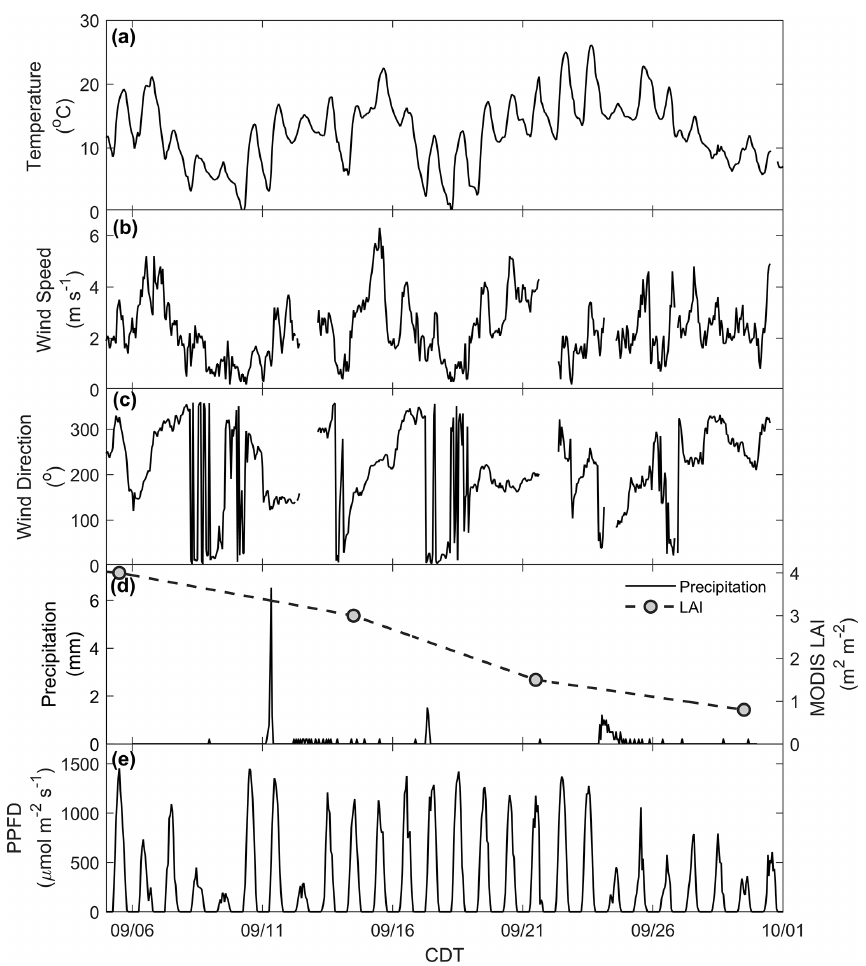
Figure 1. Meteorology at the measurement site: (a) temperature, (b) wind speed, (c) wind direction, (d) precipitation (black line) and LAI (grey dots), and (e) photosynthetic photon flux density